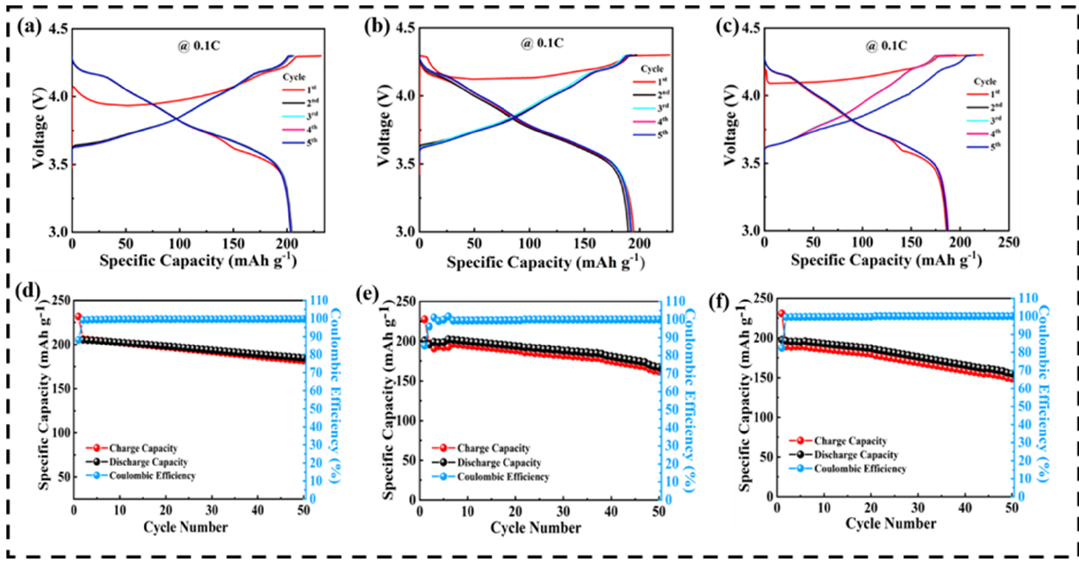
Figure 7. GCD profile of NCM811/Li half-cell using ( a ) PMC; ( b ) PM; and ( c ) PC; cyclic performance with Coulombic efficiency of NCM811/Li half-cell using ( d ) PMC-; ( e ) PM-; ( f ) PC-based GPEs.